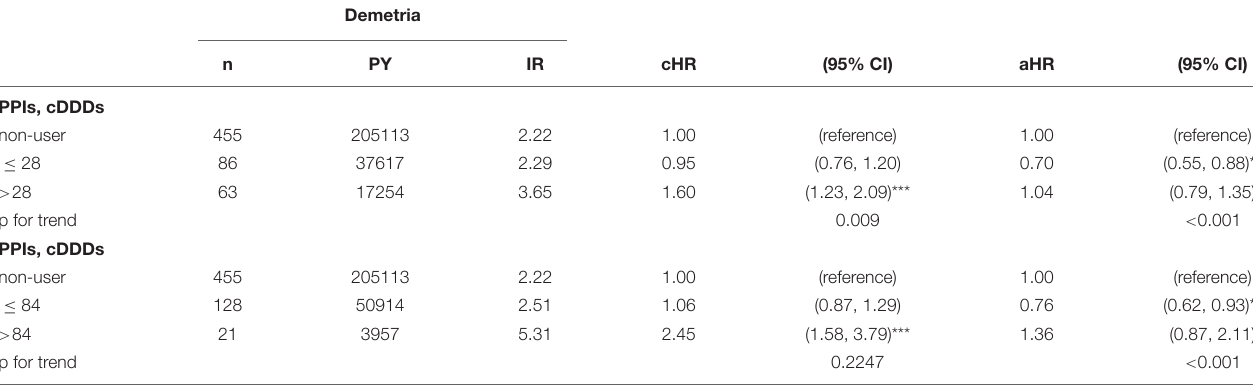
TABLE 5 | The effect of PPIS on control patients.